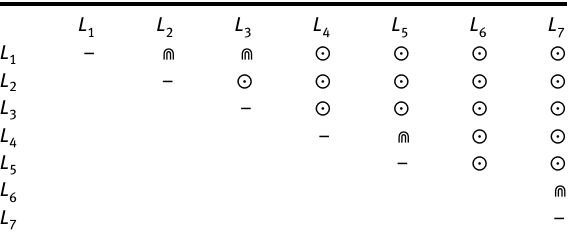
Table 7: Relation matrix of the core, illustrated in Figure 9B, of